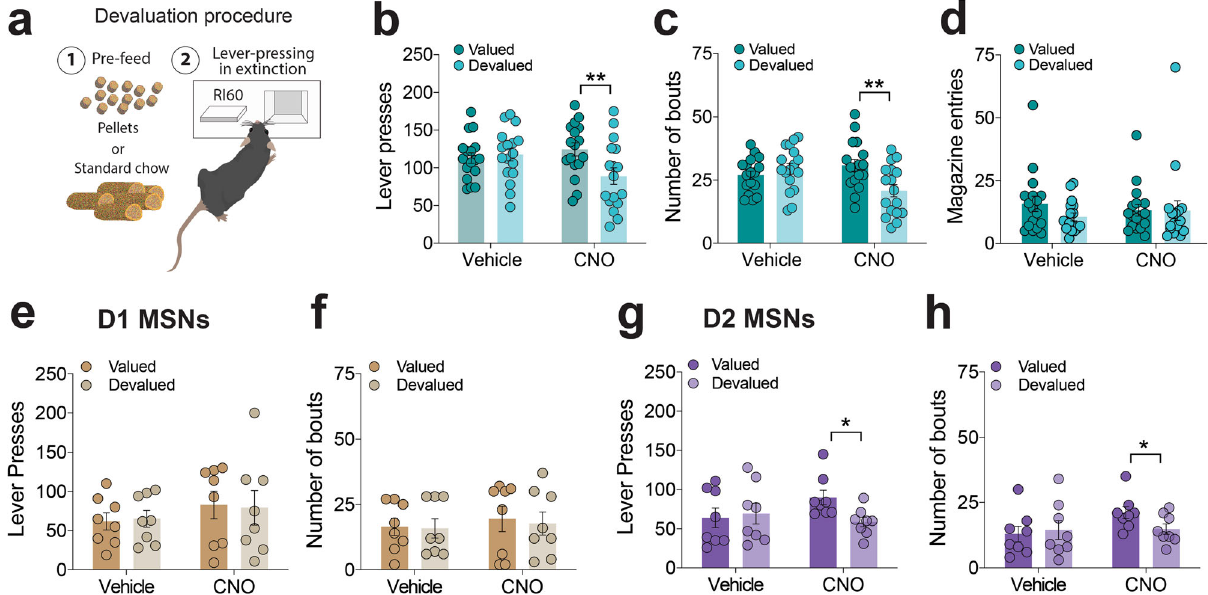
Fig. 6 D2-MSNs in aDLS regulate habitual actions. a Graphical representation of sensory-speci fi c satiety-induced devaluation procedure used to assess the goal-directedness of lever-pressing behavior. Mice were pre-fed with chow (valued condition) or pellets (devalued condition) (1), then permitted to lever-press under extinction conditions (2). b Mean (±s.e.m.) number of lever presses under extinction conditions in mice expressing hM4Di in aDLS ( n = 22) trained under an RI60 schedule after vehicle or CNO injection in valued and devalued conditions; F (1,16) = 13.84, p = 0.0019, interaction between Value and CNO in Two-way repeated measures ANOVA; ** p = 0.0035, post-hoc test. c Numbers of bouts of lever presses (±s.e.m.); F (1,16) = 17.56, p = 0.0007, interaction between Value and CNO in Two-way repeated measures ANOVA; ** p = 0.0017, post-hoc test. d Mean (±s.e.m.) number of magazine entries (±s.e.m.); F (1,16) = 1.807, p = 0.1977, interaction effect in Two-way repeated measures ANOVA. e Mean (±s.e.m.) number of lever presses under extinction conditions in D1-Cre mice expressing hM4Di in aDLS ( n = 8) trained under an RI60 schedule after vehicle or CNO injection in valued and devalued conditions; F (1,7) = 0.124, p = 0.7351; interaction effect in Two-way repeated measures ANOVA. f Mean (±s.e.m.) number of bouts of lever presses; F (1,7) = 0.1076, p = 0.7525. g Mean (±s.e.m.) number of lever presses under extinction conditions in D2-Cre mice expressing hM4Di in aDLS ( n = 8) trained under an RI60 schedule after vehicle or CNO injection in valued and devalued conditions; F (1,7) = 0.6.359, * p = 0.0397; interaction effect in Two-way repeated measures ANOVA. h Mean (±s.e.m.) number of bouts of lever presses; F (1,7) = 6.055, * p = 0.434; interaction effect in Two-way repeated measures bouts (Fig. 6h) but not their density (Supplementary Fig. 19)